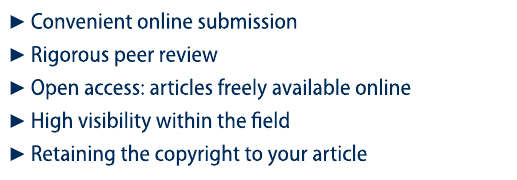
Tabor KL, Brewster CC, Fell RD (2004) Analysis of the successional patterns of insects on carrion on southwest Virginia. J Med Entomol 41:785 – 795 Tabor KL, Fell RD, Brewster CC (2005) Insect fauna visiting carrion in Southwest Virginia. Forensic Sci Int 150:73 –